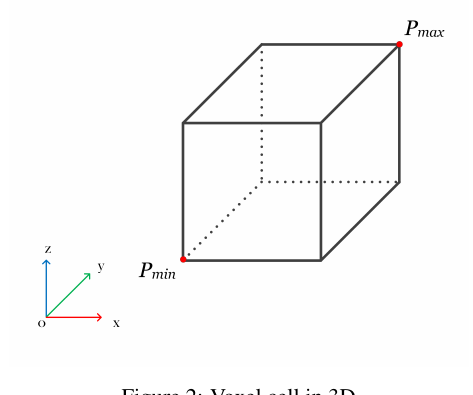
Figure 2: Voxel cell in